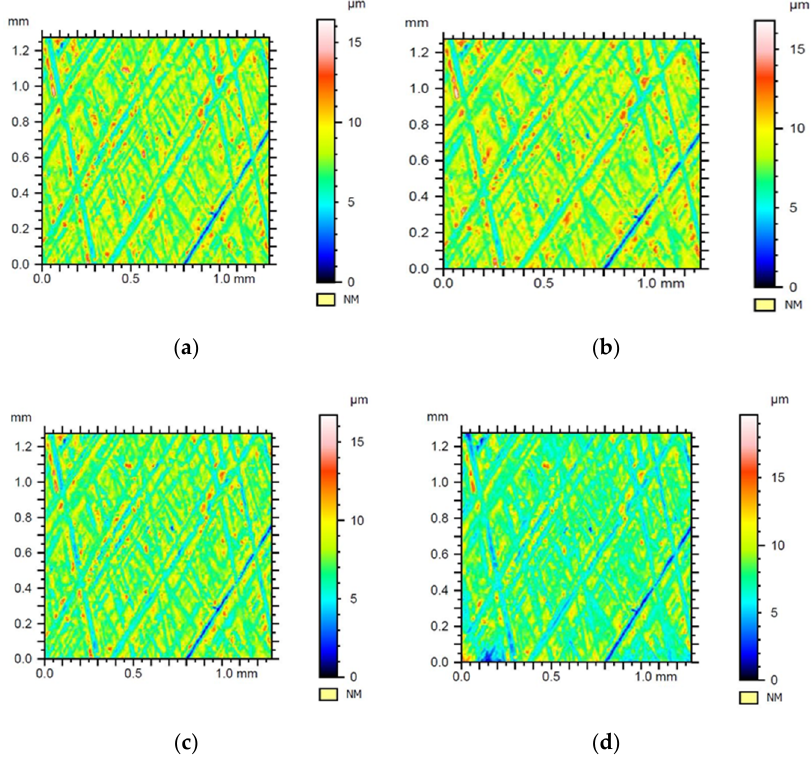
Figure 20. The surface of sample no. 3 with a flat-top structure after leveling, shape removing, and applying: ( a ) Gaussian filter, ( b ) Daubechies wavelet, ( c ) Morlet wavelet, ( d ) Mexican hat wavelet. The results for the root mean square errors for sample 3 were higher than for sample